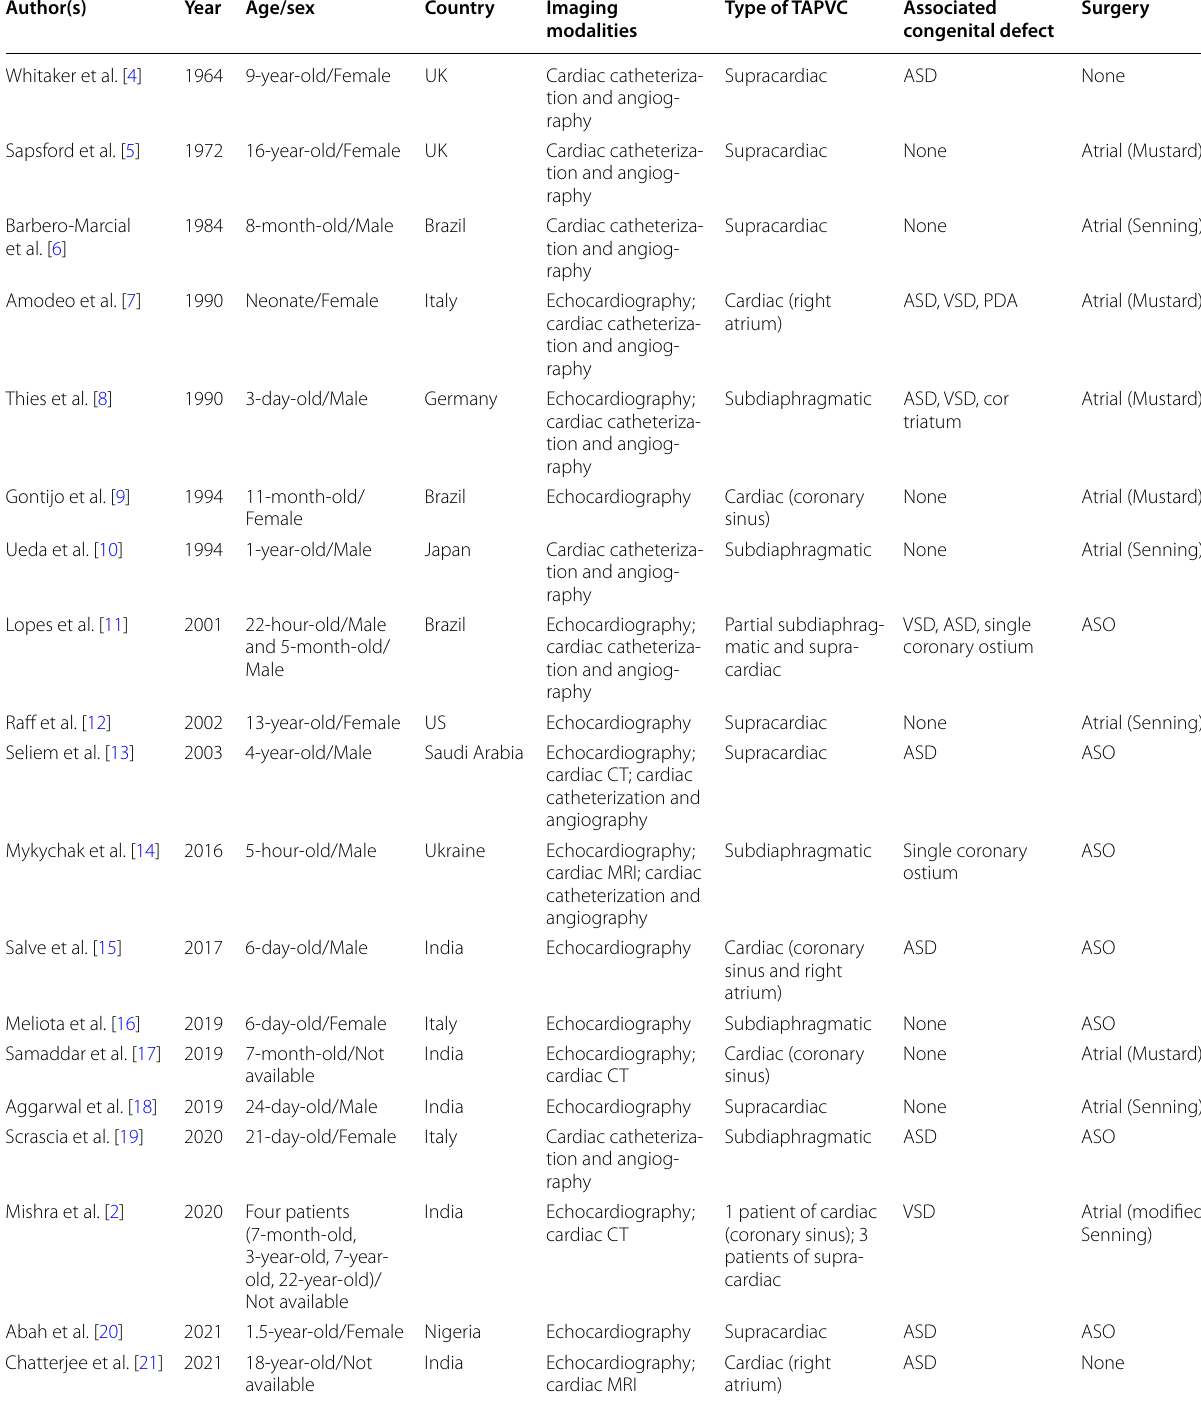
Table 1 Cases of coexisting D-TGA and TAPVC reported in the